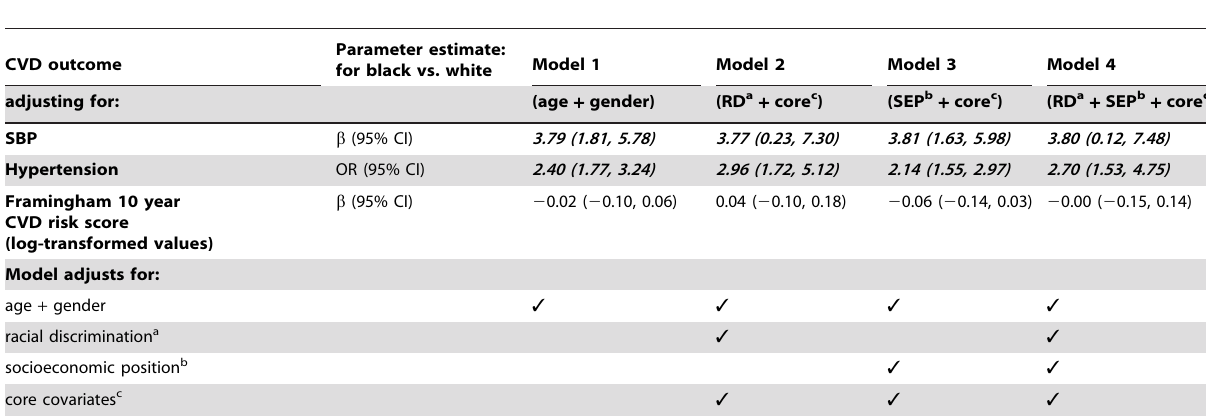
Table 6. Black vs. white difference: effect of adjusting for racial discrimination (RD) a and socioeconomic position (SEP) b , separately and jointly (imputed